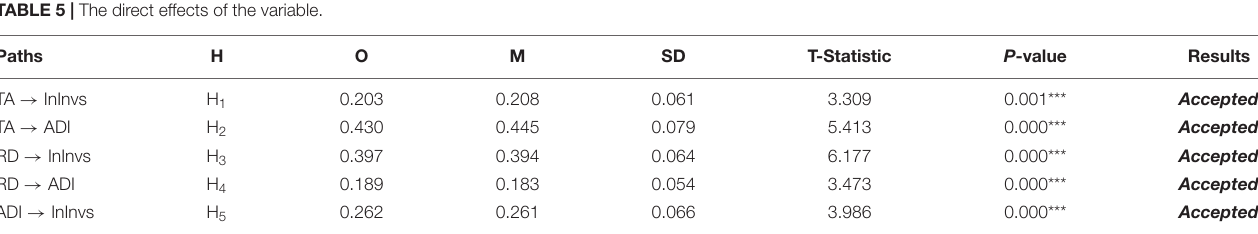
TABLE 5 | The direct effects of the